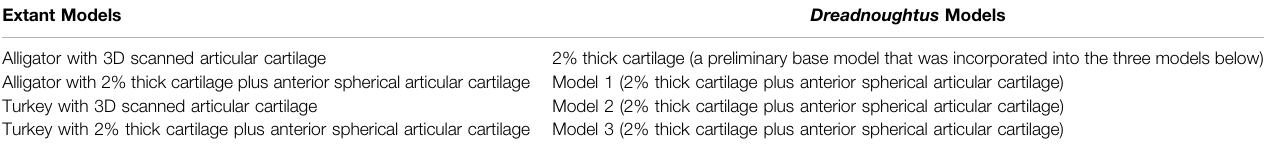
TABLE1| Summaryofthemodelsconstructedforsimulationsinthisstudy.Adams ™ fi lesavailableat[https://doi.org/10.6084/m9. fi gshare.c.6022103.v1 fi gsharelinkonce